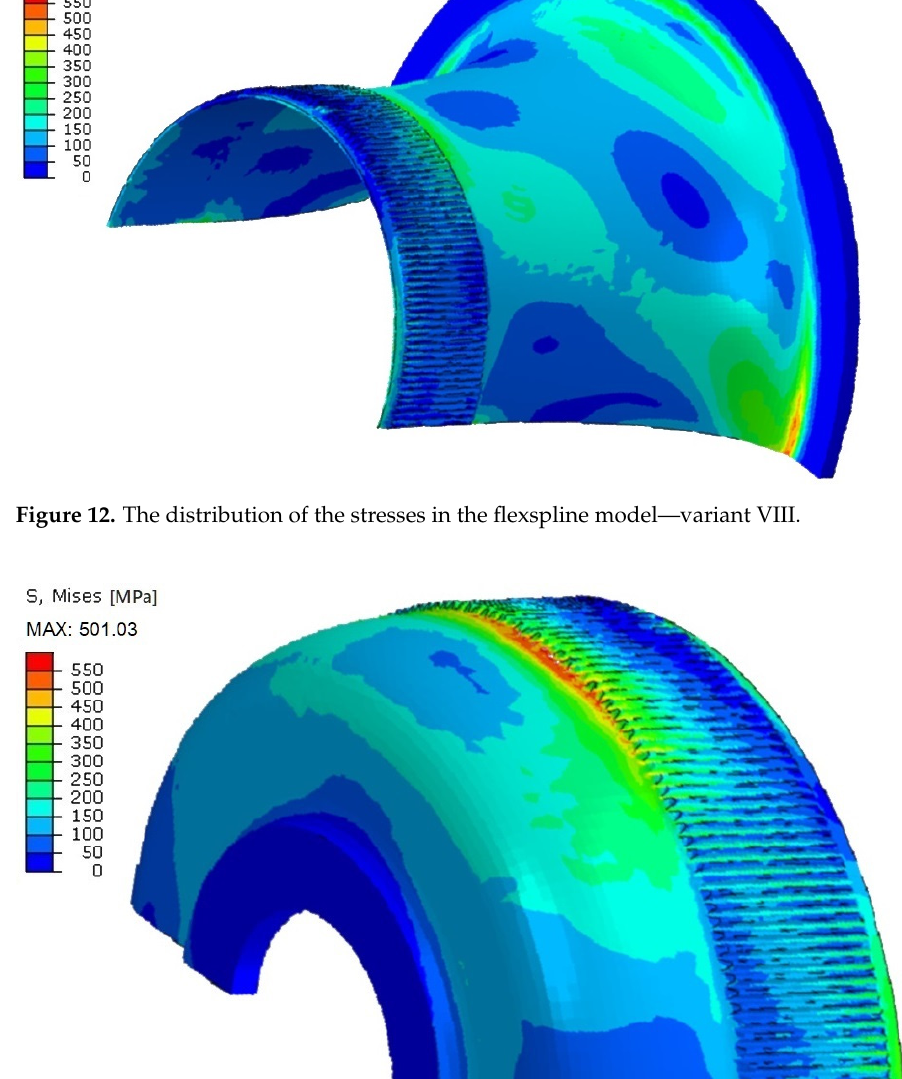
Figure 11. The distribution of the stresses in the flexspline model—variant VII.